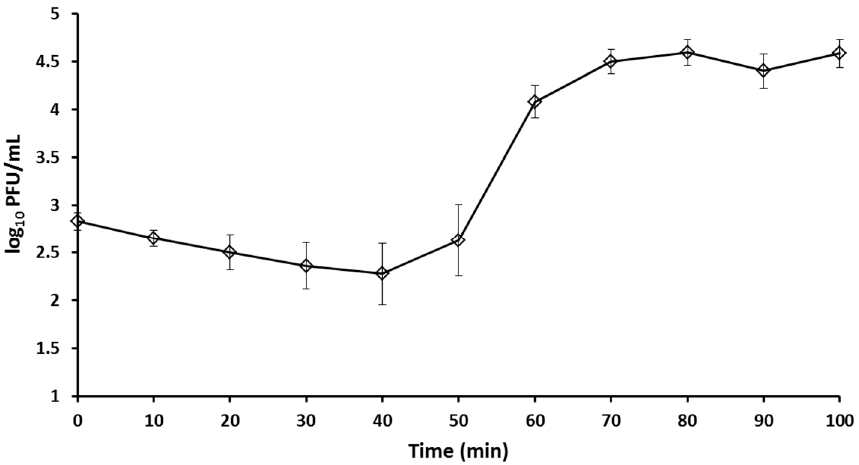
Figure 2. One step growth curve of bacteriophage BSP10. Error bars represent standard deviation.